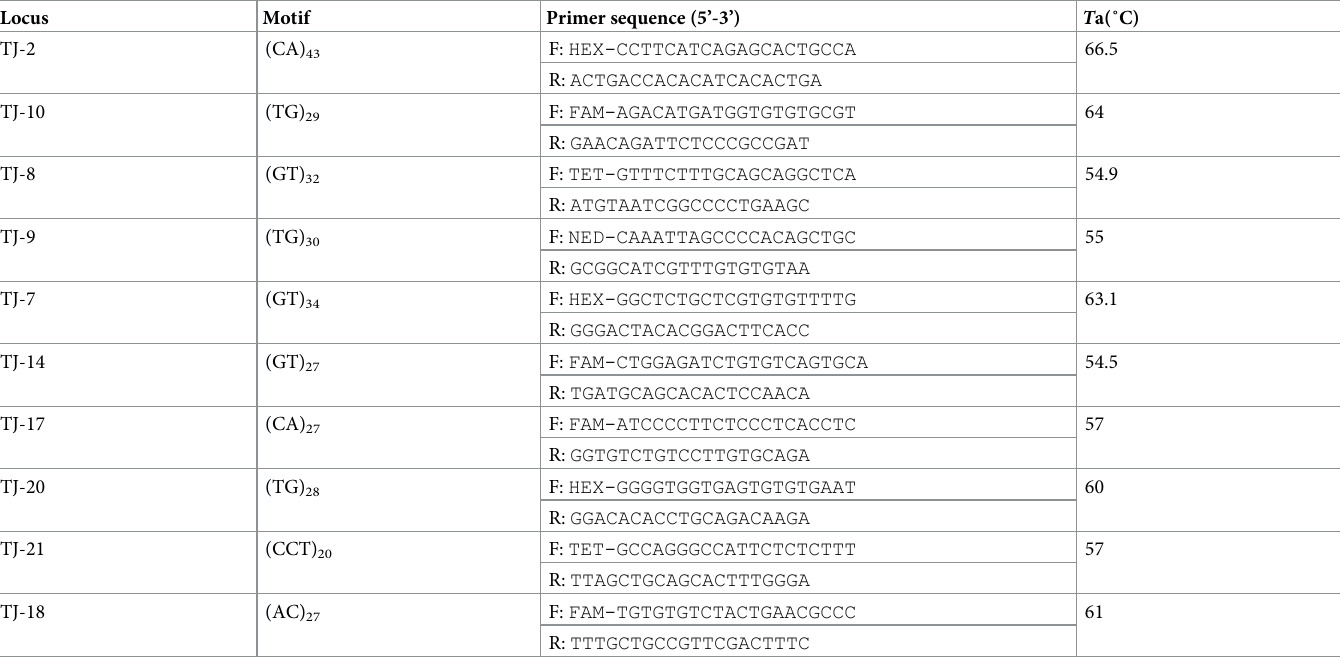
Table 2. The characteristics of the ten microsatellite loci of T . japonicus developed from the transcriptome dataset.